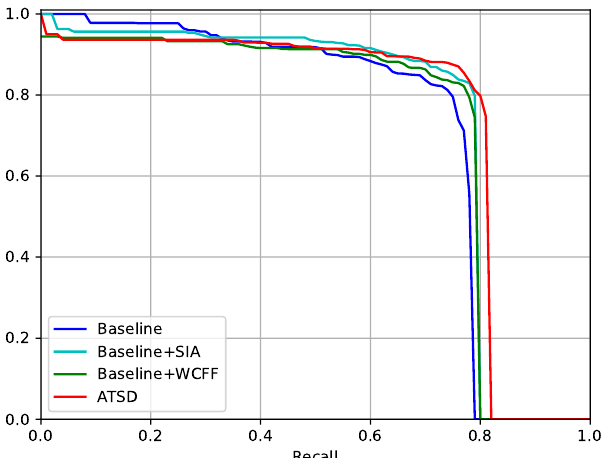
Figure 10. PR curves of different feature enhancement modules under the IoU threshold of 0.75 on the SSDD dataset.